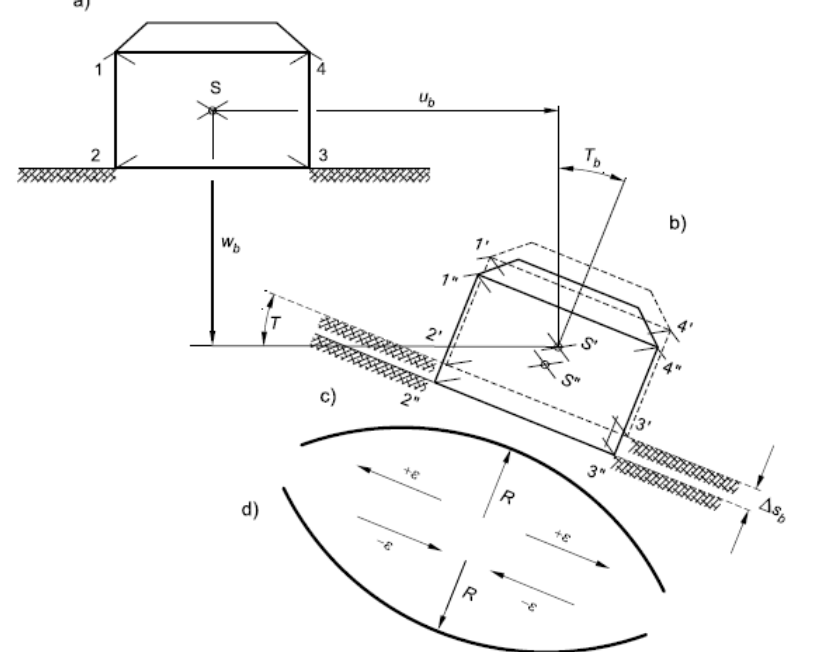
Figure 3. Diagram of the building in any position on the basin: ( a ) starting position; ( b ) position after displacement; ( c ) convex basin rim; ( d ) concave basin rim [30]. Reproduced with permission from [30]; published by Wydawnictwo ITB, 2021.